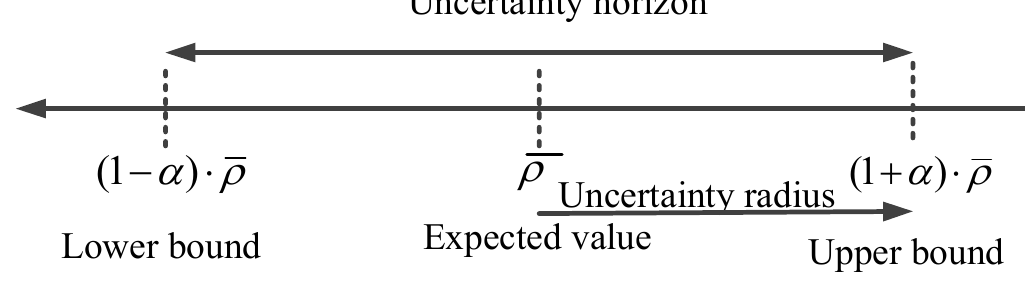
Figure 3. The uncertainty bounds